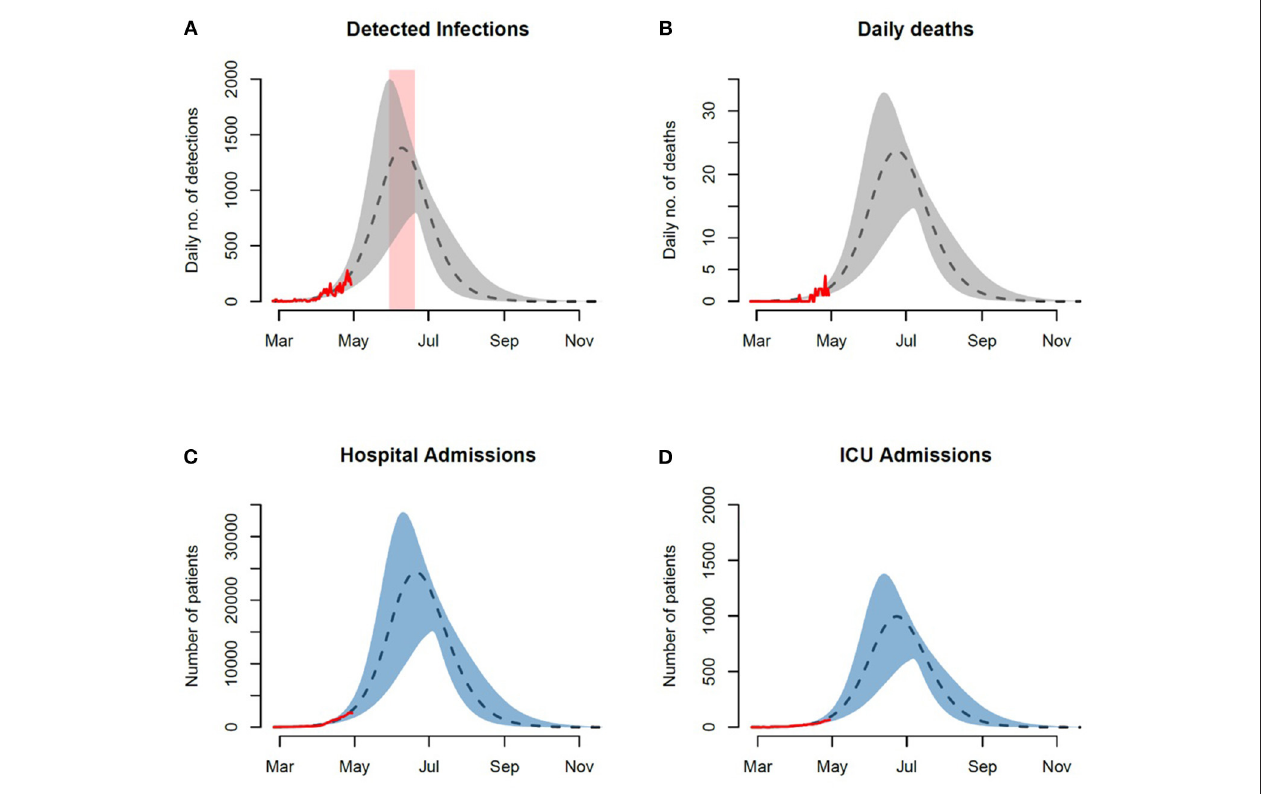
FIGURE 4 | Tripling the size of the unprotected susceptible population. Peaks of forecasted trajectories are approximately tripled in size. The projected time-window of the peak is delayed by 2-weeks and widened (3-week period). Observed and projected daily numbers of (A) incident infections, (B) death cases, (C) general hospital admissions, and (D) ICU admissions. Red rectangular ribbon highlights the projected time-window of the epidemic peak. Red lines represent the reported data. Black dashed lines represent model projections based on MLE of unknown parameters with shaded ribbons representing 95% credible interval on new observations. We note here that the observed cases and their projections only represent a fraction of the actual and model prevalence. This is based on our assumption of under-reporting and the presence of asymptomatic individuals in the population.